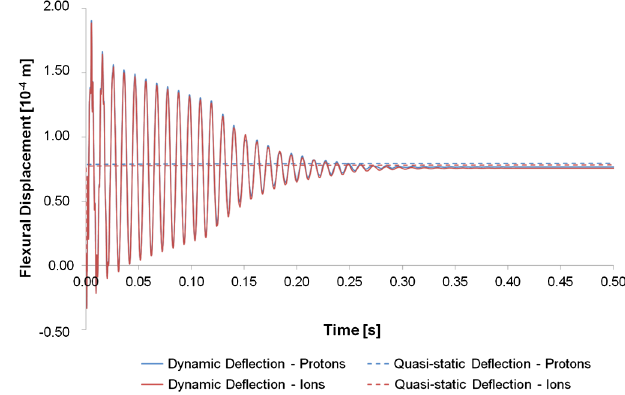
FIG. 15. Dynamic flexural displacement (x-direction) of the collimator jaw assembly as provoked by the proton (1 bunch with 4 . 48 × 10 9 protons) beam impact, and as provoked by the ion (1 nominal ion bunch) beam impact. The quasistatic deflection due to the thermal bending moment is also shown for both cases. No significant difference can be observed between the proton and ion case